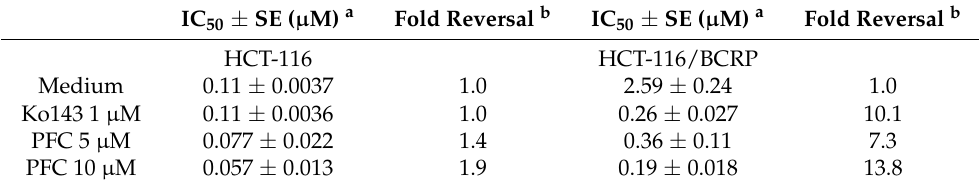
. Figure 1. High-throughput screening and validation assay identifying 16 candidate ABCG2 inhibitors. ( A ) Dot plot of PhA efflux data from high-throughput screening. Of 5812 compounds, 23 exhibited higher fluorescence intensities than Ko143. ( B ) Dot plot of PhA efflux data for validation by flow cytometry. Of 22 compounds (there was an overlap for one of the compounds, the number of candidates was reduced to 22), 16 showed higher fluorescence intensities than Ko143. Table 1. The phenylfurocoumarin derivative PFC reverses ABCG2-mediated drug resistance to